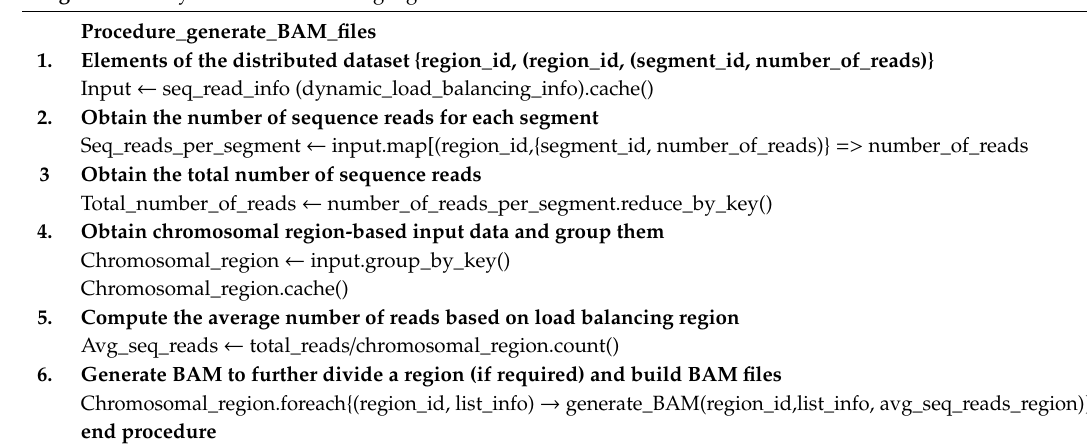
Algorithm 1. Dynamic load balancing